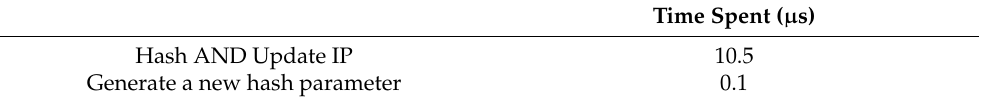
Table 2. The overhead (time) of generating a sha-256 based synchronous signature.